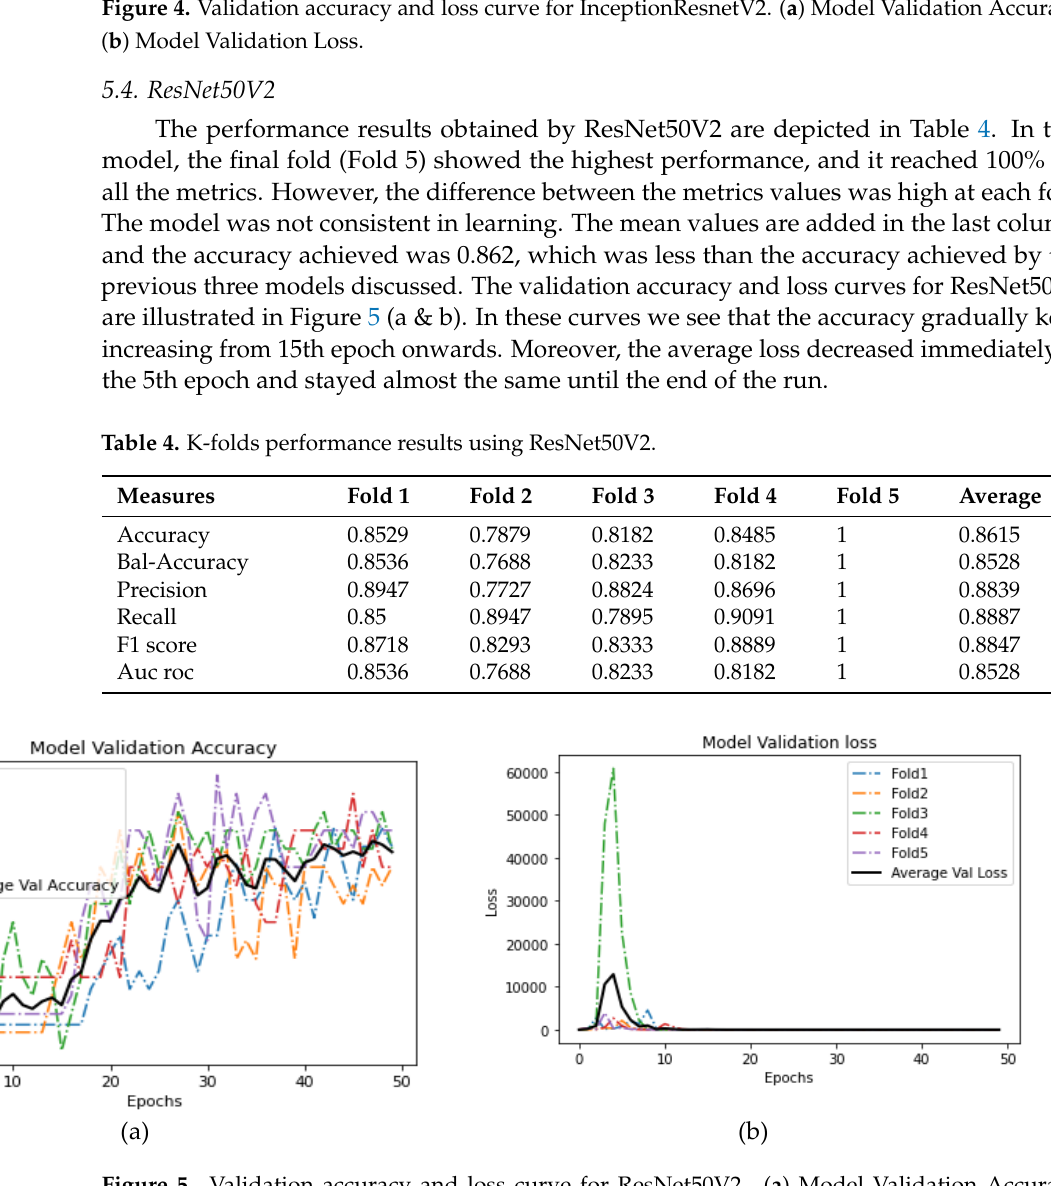
Figure 5. Validation accuracy and loss curve for ResNet50V2 . (a) Model Validation Accuracy; (b) Model Validation Loss.